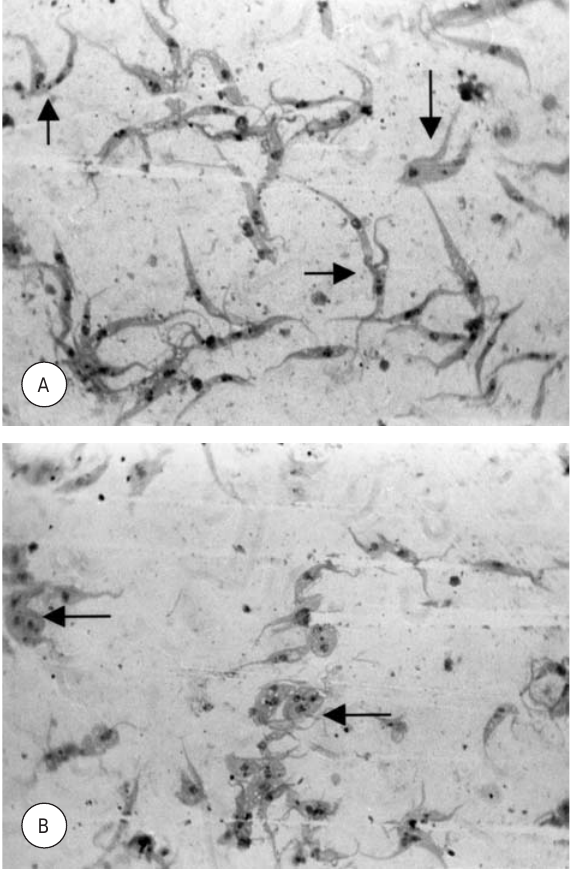
FIG. 7 Different dividing stages of trypanosomes in the haemo-